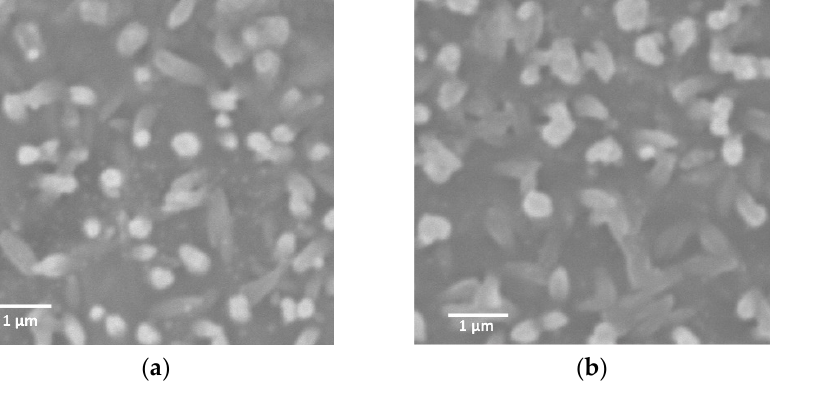
Figure 2. SEM images of ( a ) 1 /[Au(CN) 2 ] − , ( b ) 2 /[Au(CN) 2 ] − , and ( c ) 3 /[Au(CN) 2 ] − , where [Au(CN) 2 ] − = 3.5 mM.